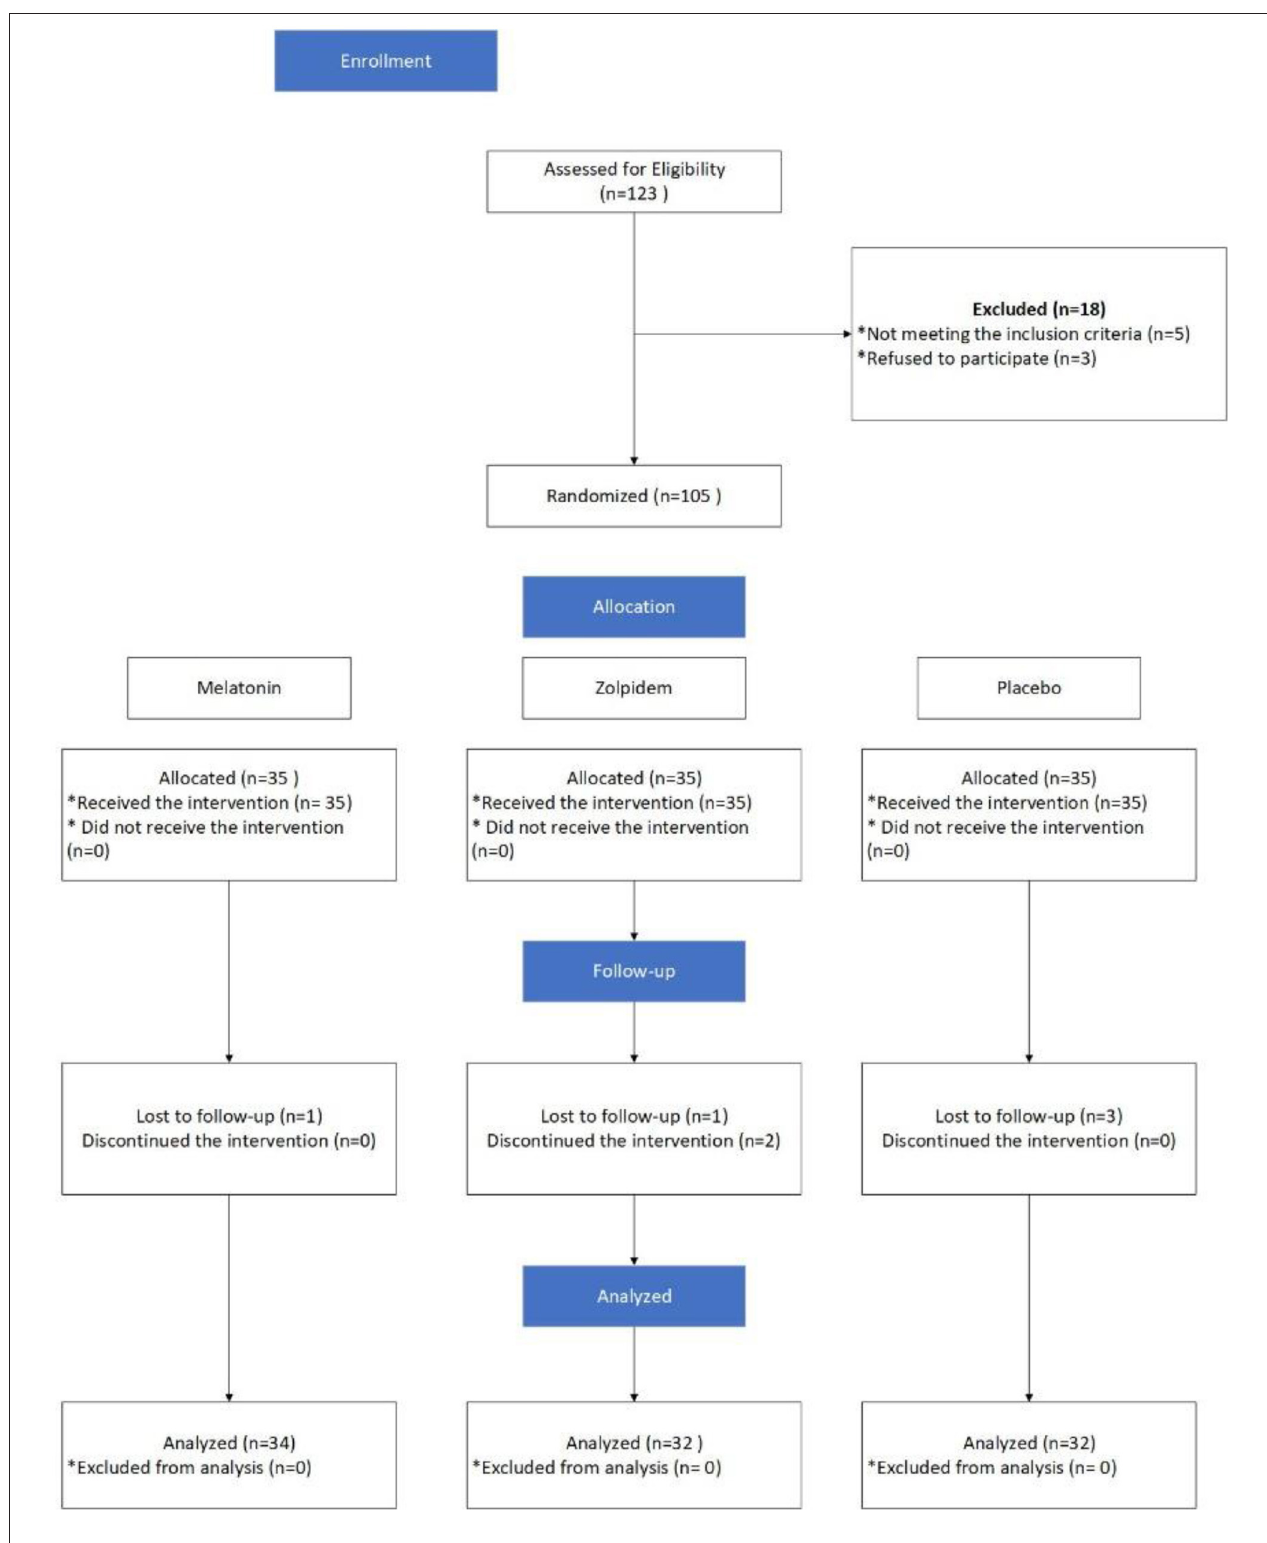
FIGURE 1 | Allocation process of the